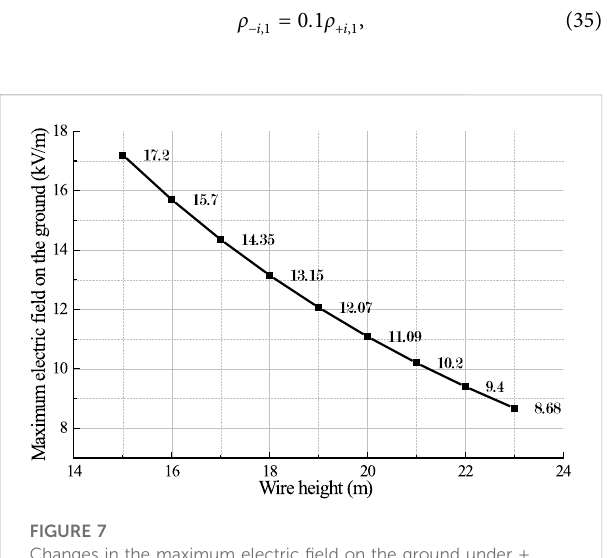
FIGURE 7 Changes in the maximum electric fi eld on the ground under ± 800 kV power lines with different heights above